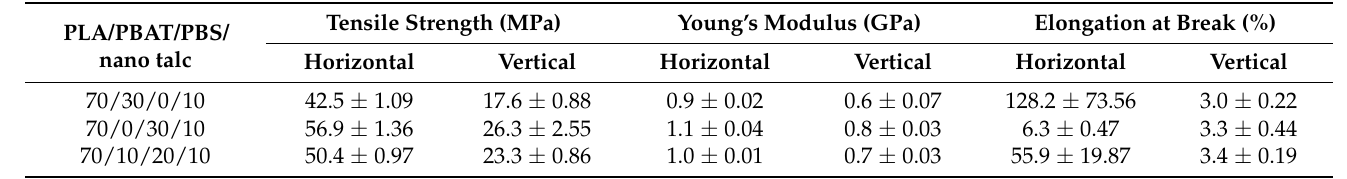
Table 5. Tensile properties of PLA/PBAT/PBS/nano talc composite 3D prints.